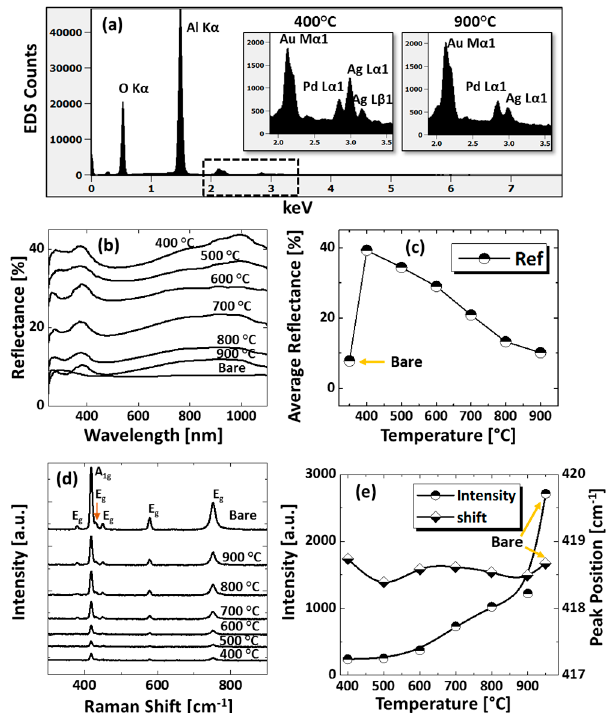
Figure 3. ( a ) EDS spectra between 0 to 7.5 keV of the samples at 400 °C and 900 °C. ( b ) Reflectance spectra of tri-metallic NPs at various temperatures on sapphire (0001) as a function of wavelength. ( c ) Summary plot of average reflectance. ( d ) Raman spectra of the samples. ( e ) Summary plots of peak intensity and peak position with respect to the temperature.